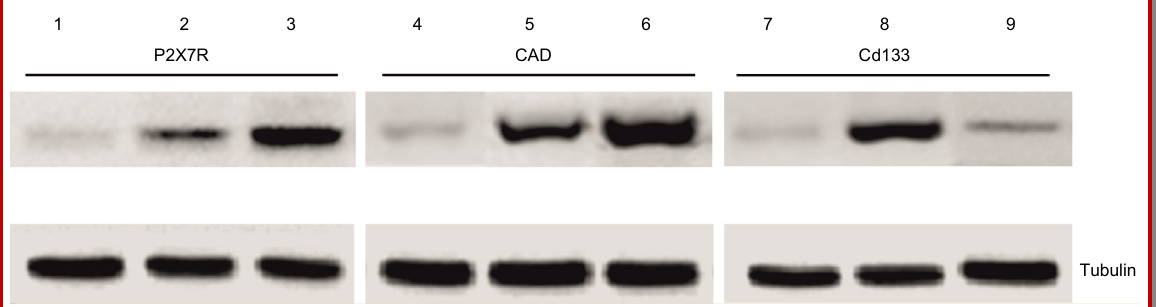
Figure 3: Expression pattern of P2X7R, apoptotic and CD133 in normal and acute kidney injury tissue. Lane 1 to lane 3 represents P2X7R expression in normal kidney tissue, samples from acute kidney injury tissues of day 2 and day 4 respectively. Lane 4 to lane 6 represents CAD expression in normal kidney tissue, samples from acute kidney injury tissues of day 2 and day 4 respective- ly. Lane 6 to lane 9 represents CD133 expression in normal kidney tissue, samples from acute kidney injury tissues of day 2 and day 4 respectively. For all the experiments, tubulin was used as the loading